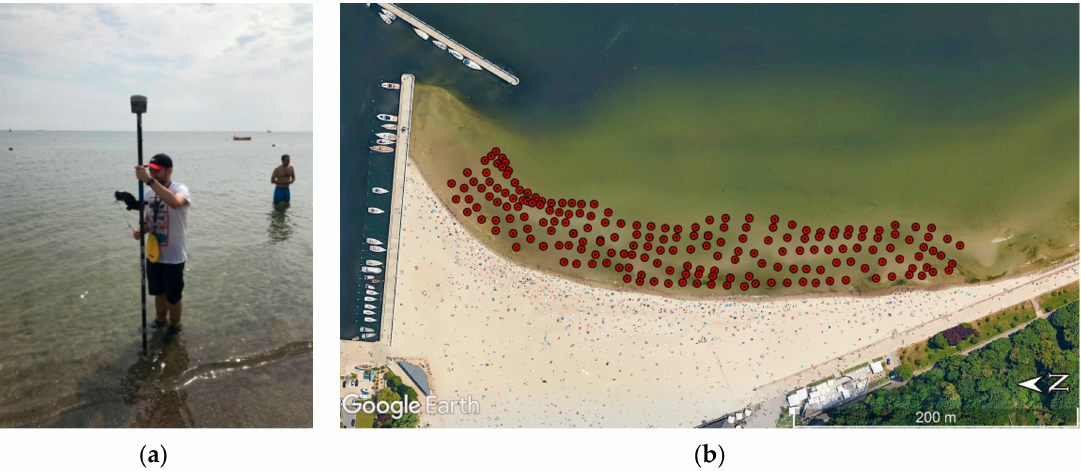
Figure 2. A hydrographer during bathymetric surveys on an ultra-shallow waterbody ( a ), and the coverage area being surveyed with measurements ( b ) using the geodetic